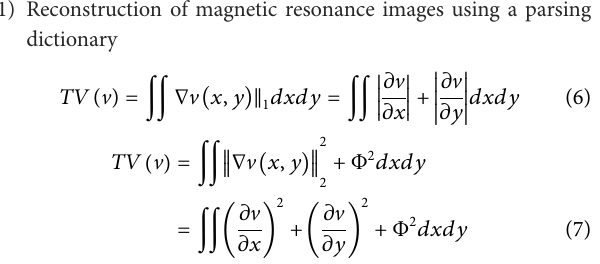
TABLE 2 Comparison of MR staging and pathological T staging. Pathological staging MR staging